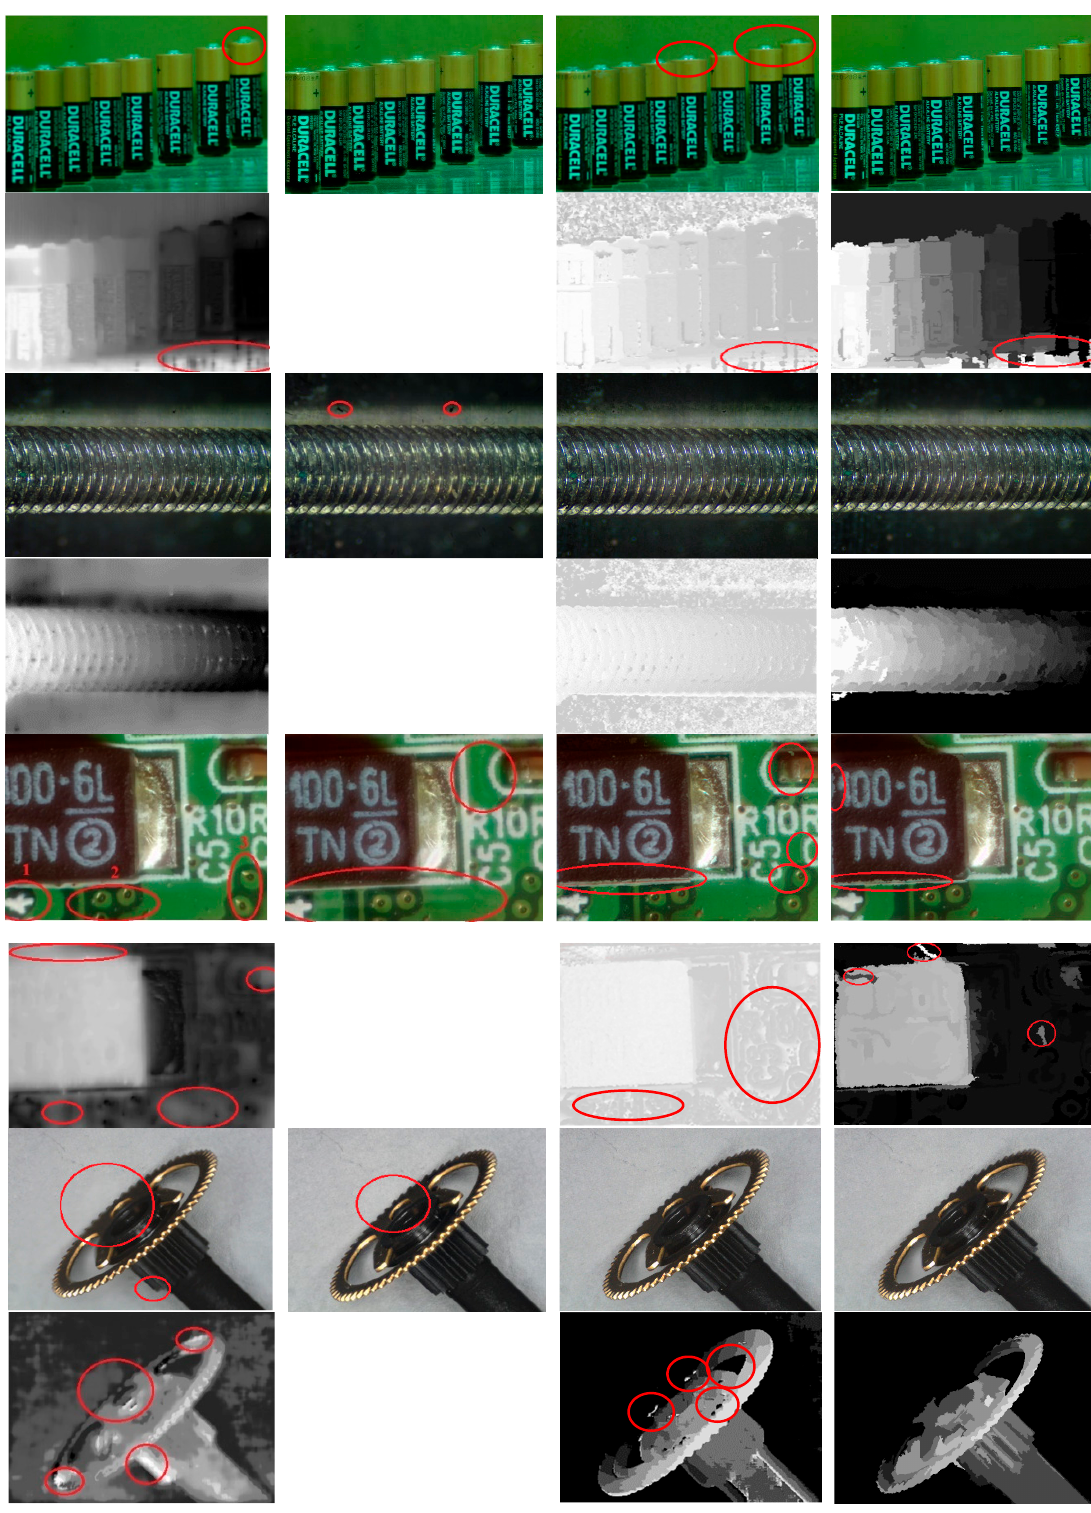
Figure 11. Results of AIF images ( odd rows ) and depth maps ( even rows ) for “Battery”( rows 1–2 ), “Screw” ( rows 3–4 ), “PCB” ( rows 5–6 ), and “Tool” ( rows 7–8 ) obtained by Helicon ( column 1 ), Zerene Stacker ( column 2 ), [12] ( column 3 ), and proposed method ( column 4 ).